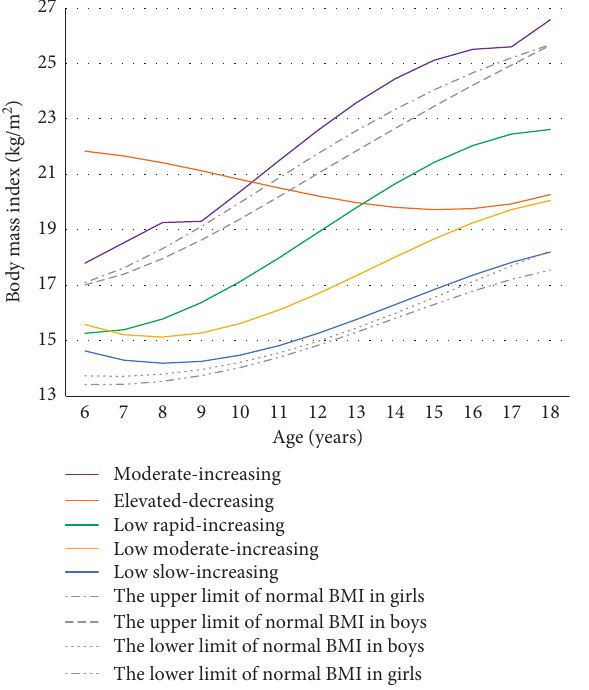
Figure 2: BMI trajectories from 6 to 18